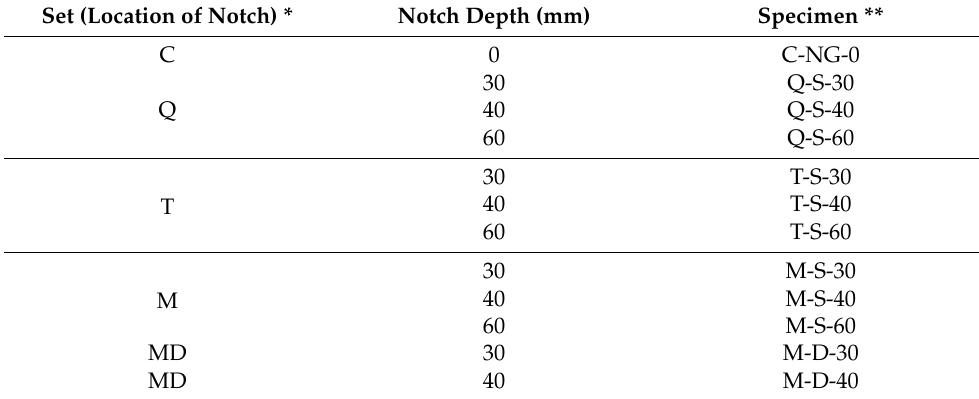
Table 2. Test matrix—specimen categorizing. Set (Location of Notch) * Notch Depth (mm) Specimen ** C 0 C-NG-0 30 Q-S-30 40 Q-S-40 Q 60 Q-S-60 30 T-S-30 40 T-S-40 T 60 T-S-60 30 M-S-30 40 M-S-40 M 60 M-S-60 MD 30 M-D-30 MD 40